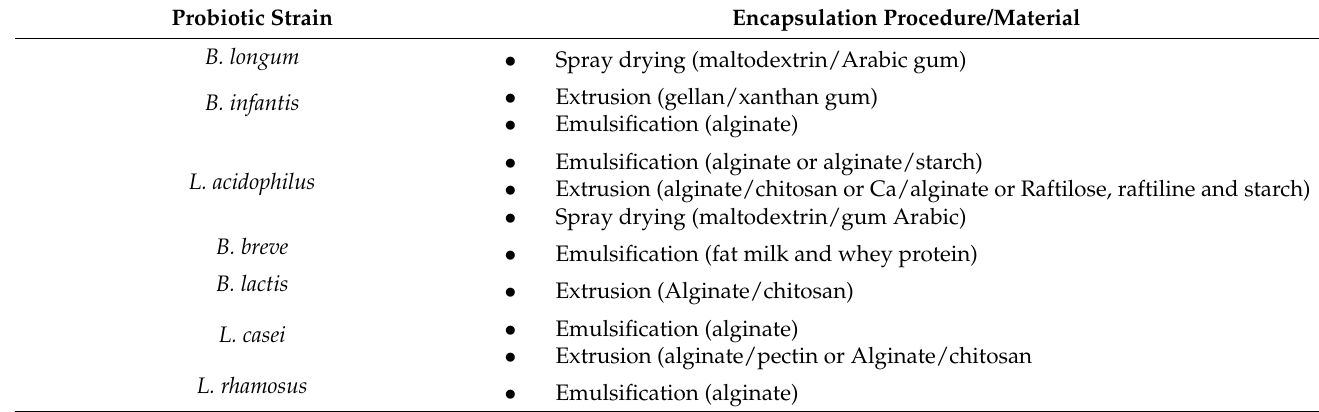
Table 3. Some probiotic strains to add encapsulated to yogurt